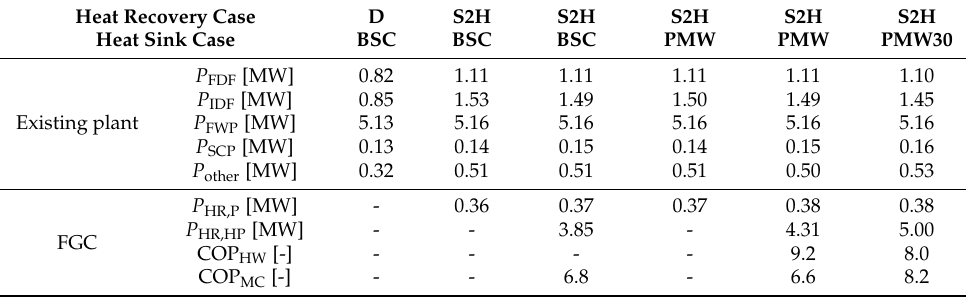
Table A4. Auxiliary power consumption of the simulated cases with